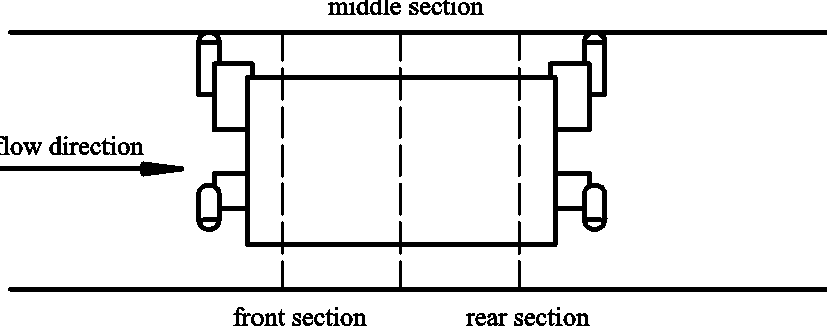
Figure 12. Schematic diagram of section division of capsule.